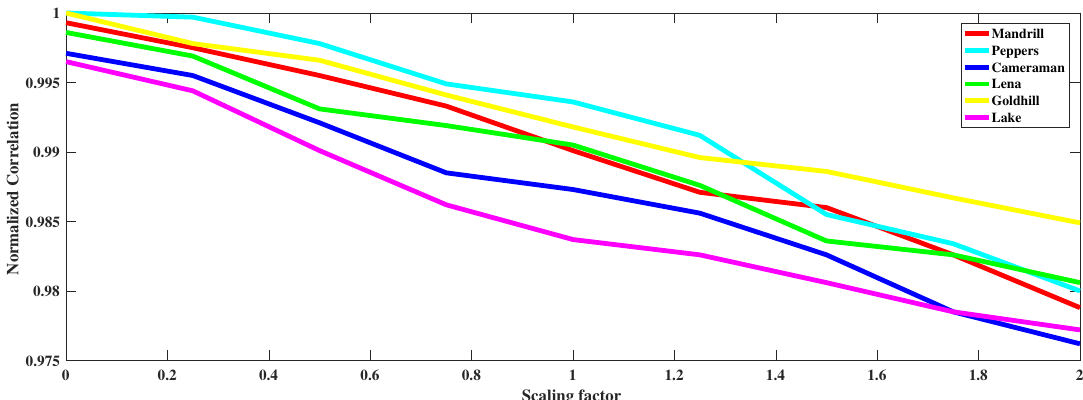
Figure A2. Robustness in terms of NC against scaling attack for several test